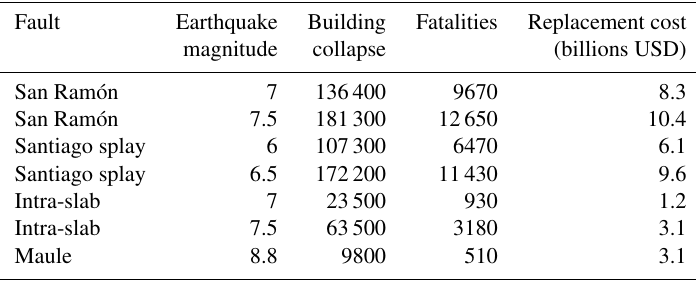
Table 5. Summary of losses from each fault and earthquake